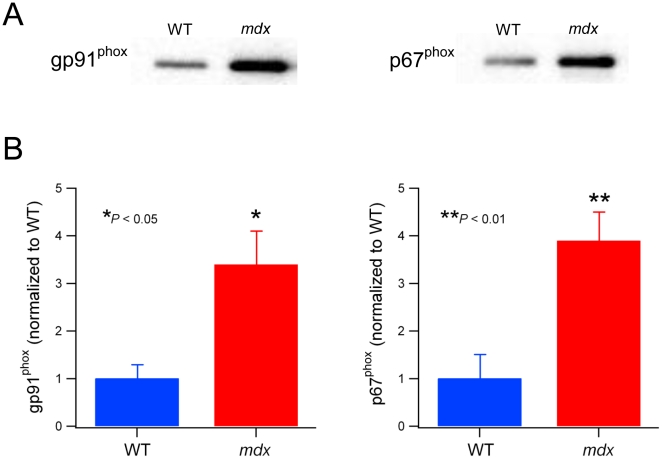
NADPH oxidase subunits are increased in 9 week old mdx mice.A. Representative western blots of gp91phox and p67phox from 9 week old WT and mdx TA muscles. B. Pooled results of densitometry analysis for gp91phox and p67phox from WT (n = 4) and mdx (n = 8) muscles.